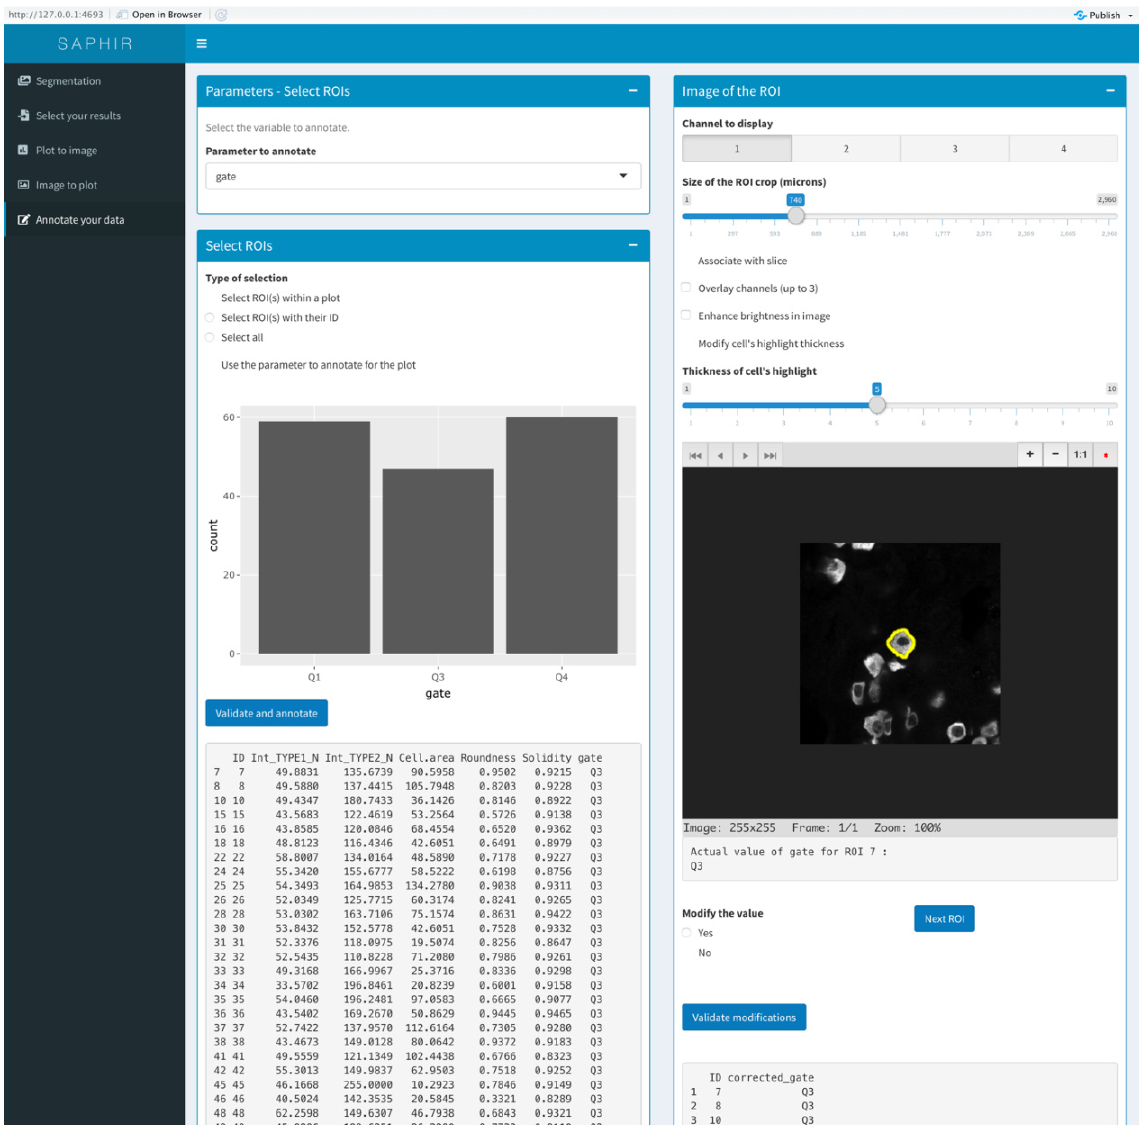
Figure 5. Menu “Annotate your data” of SAPHIR application. The results to annotate can be selected based on the Plot to Image scatterplot gated cells that have been previously saved (left panel). Each cell of the selection can be visualized in the image (right panel) with the possibility to change image size (magnification), the displayed channel(s), the slice (z optical section) and the brightness. Based on the different analysis, results for the selected COI can be modified and final results saved and exported.